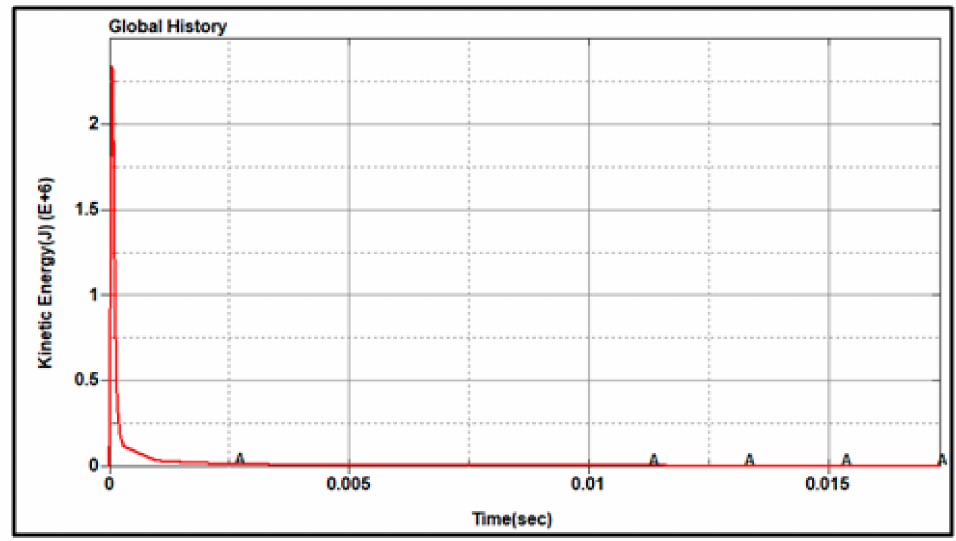
Figure 6. Kinetic Energy